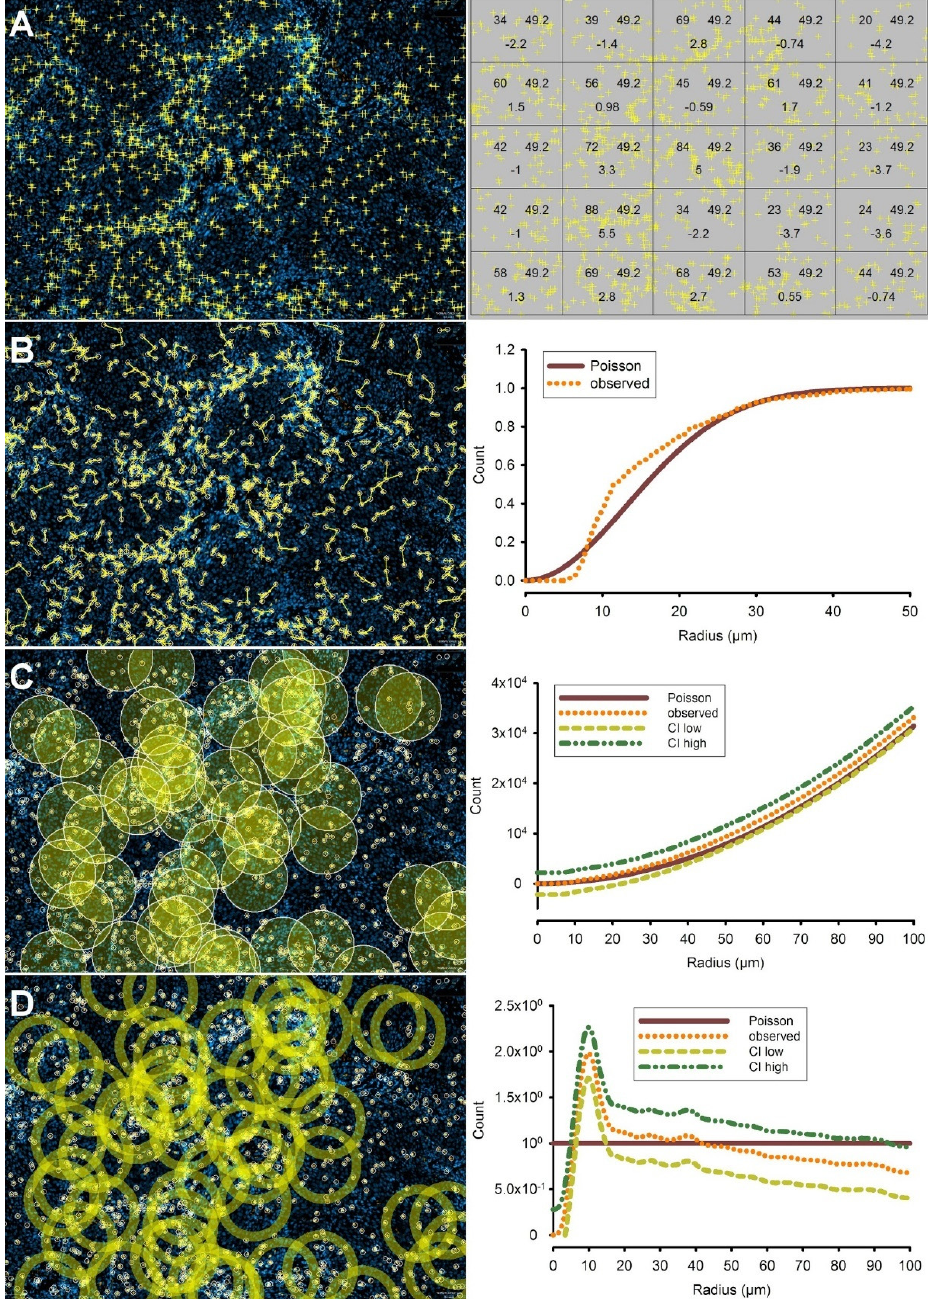
Figure 2. ( A ) The most simple method to assess clustering of cells is the quadrat test . Left panel: distribution of CTL (yellow) in the same region of a squamous cell carcinoma of the head and neck depicted in Figure 1. Clustering is less evident visually when CTL are viewed separately, outside of the context of tumor and stroma areas. First, the quadrat test (right panel) shows statistically significant inhomogeneity ( p < 2.2 × 10 − 16 ). The numbers within the quadrats (from left to